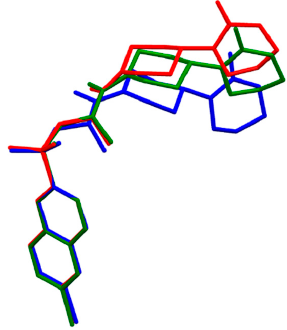
Figure 5. Molecular superimposition of the Becke3LYP optimized molecular structure of letaxaban ( green ), in solution optimized letaxaban ( red ) and letaxaban from the co-crystal with coagulation factor Xa, PDB.3KL6 ( blue ). For simplicity the hydrogen atoms are omitted.